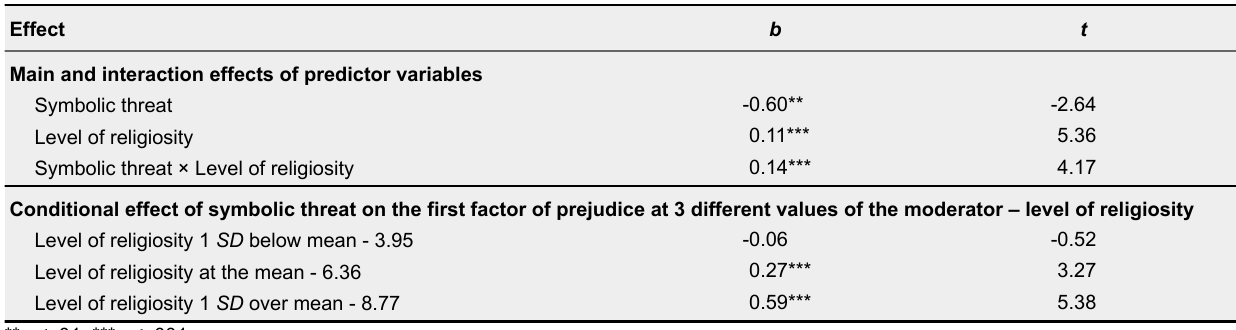
Conditional effect of symbolic threat on the first factor of prejudice at 3 different values of the moderator – level of religiosity Level of religiosity 1 SD below mean - 3.95 Level of religiosity at the mean -